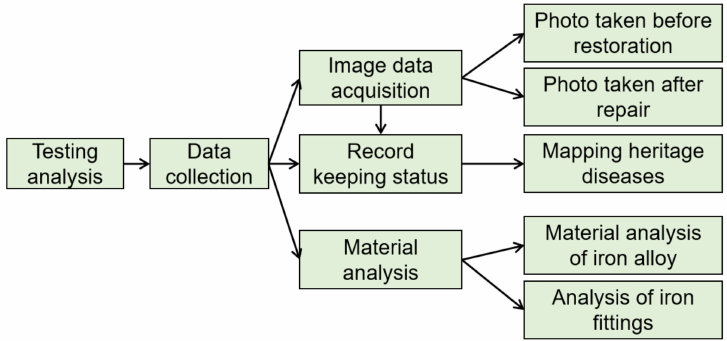
Figure 1. Flow chart describing the analysis and detection of iron